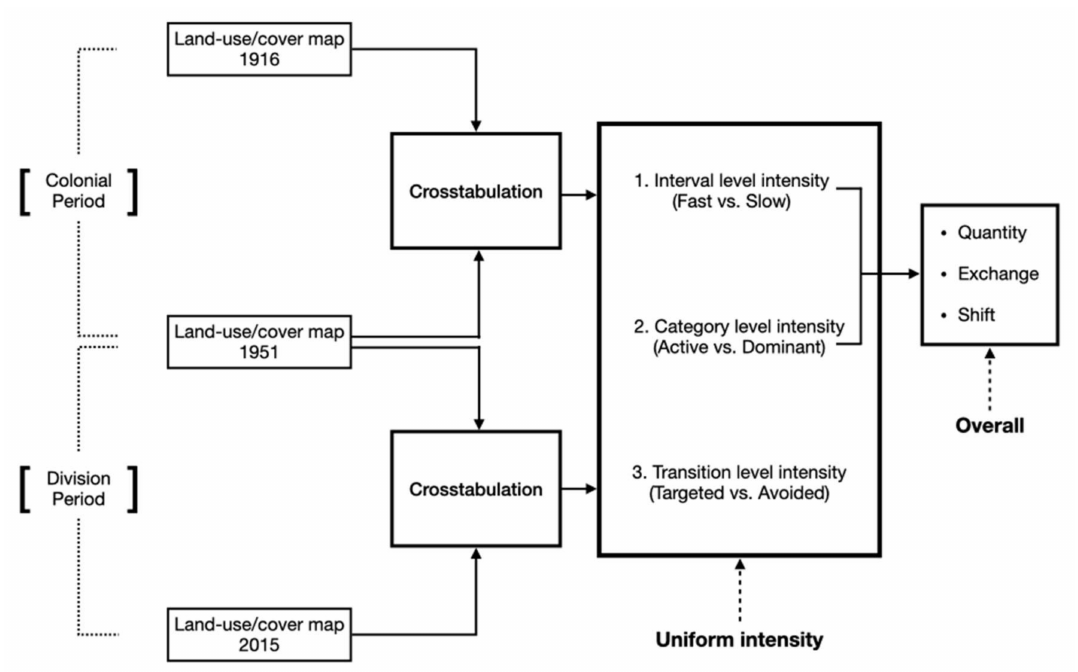
Figure 3. Conceptual diagram of methodology for the analysis of three intensity levels and change